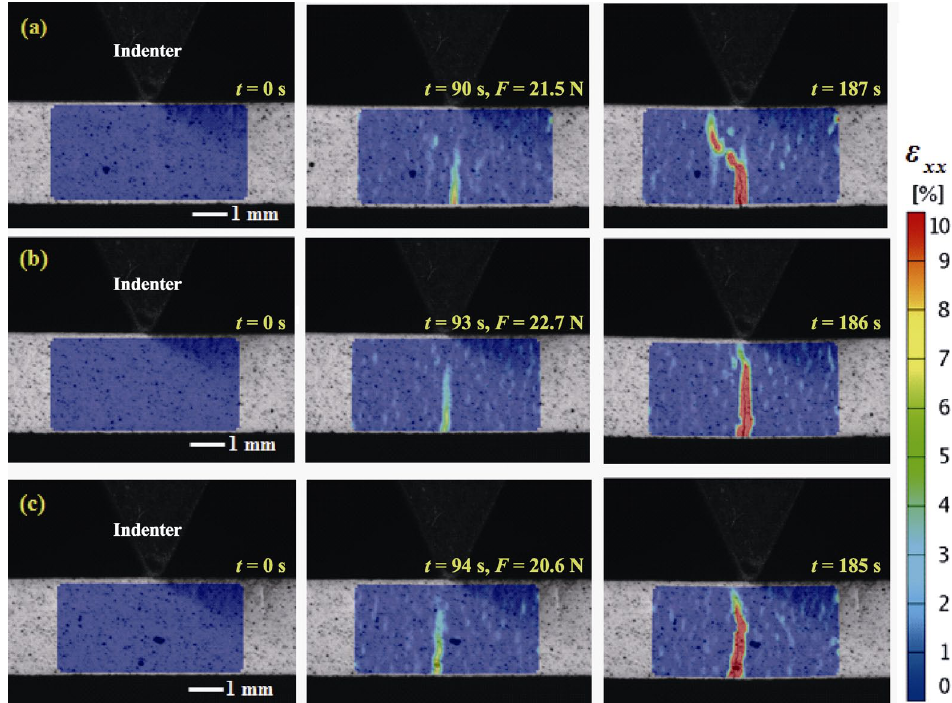
Fig. 6 Evolution of strain mapping of three GYbZ coating samples during bending tests: (a) 1# specimen, (b) 2# specimen, and (c) 3# specimen. Here F denotes the breaking load, corresponding to the cracking